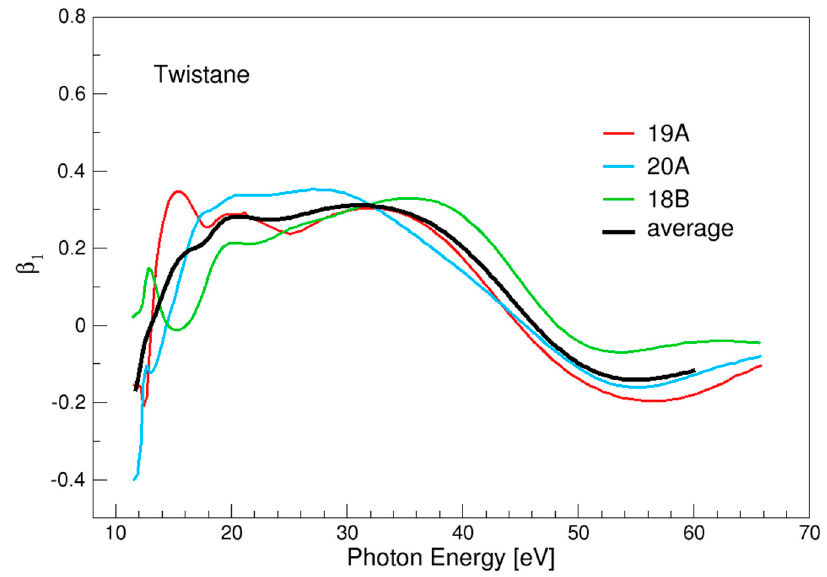
Figure 6. β 1 parameter for the three outermost ionizations, 19A, 20A and 18B, and the average value, in twistane.